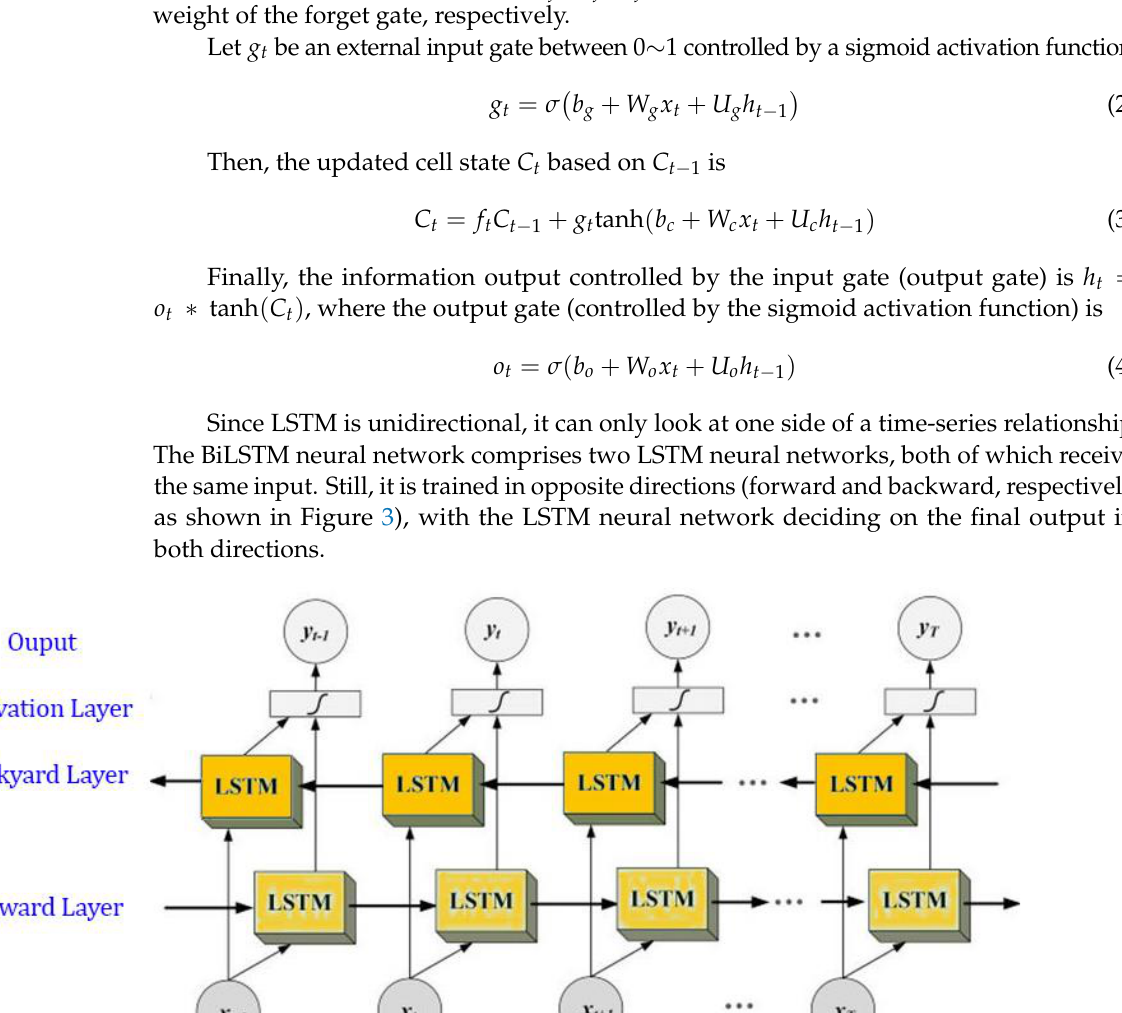
Figure 3. BiLSTM basic architecture [38].